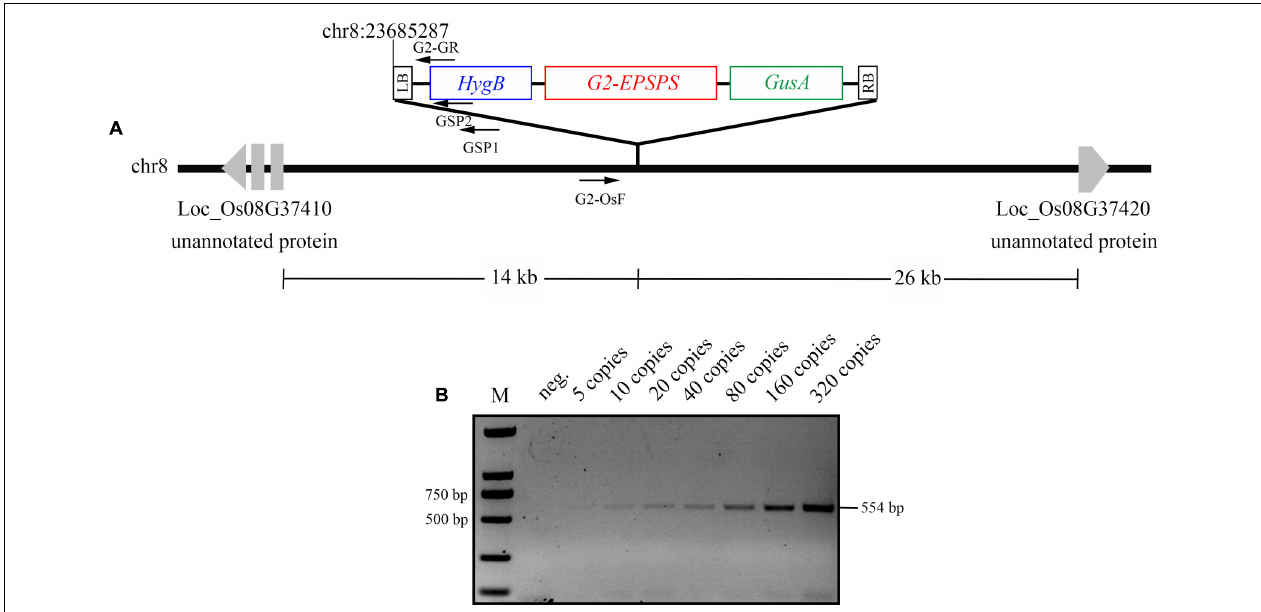
FIGURE 5 | Integration-site analysis and integration-event-specific PCR analysis. (A) The T-DNA LB integration site was identified by GenomeWalker PCR with specific primers GSP1, GSP2. The event-specific primers G2-OsF/G2-GR were designed according to the 5 (cid:48) -flanking sequence of the T-DNA of G2-6 transgenic rice and the left-border sequence of 13UG2. (B) Identification of the detection limit of transgenic plants by integration-event-specific PCR. Transgenic plant G2-6 template DNA copies were diluted to concentrations of 5, 10, 20, 40, 80, 160, and 320 copies as templates for integration-event-specific